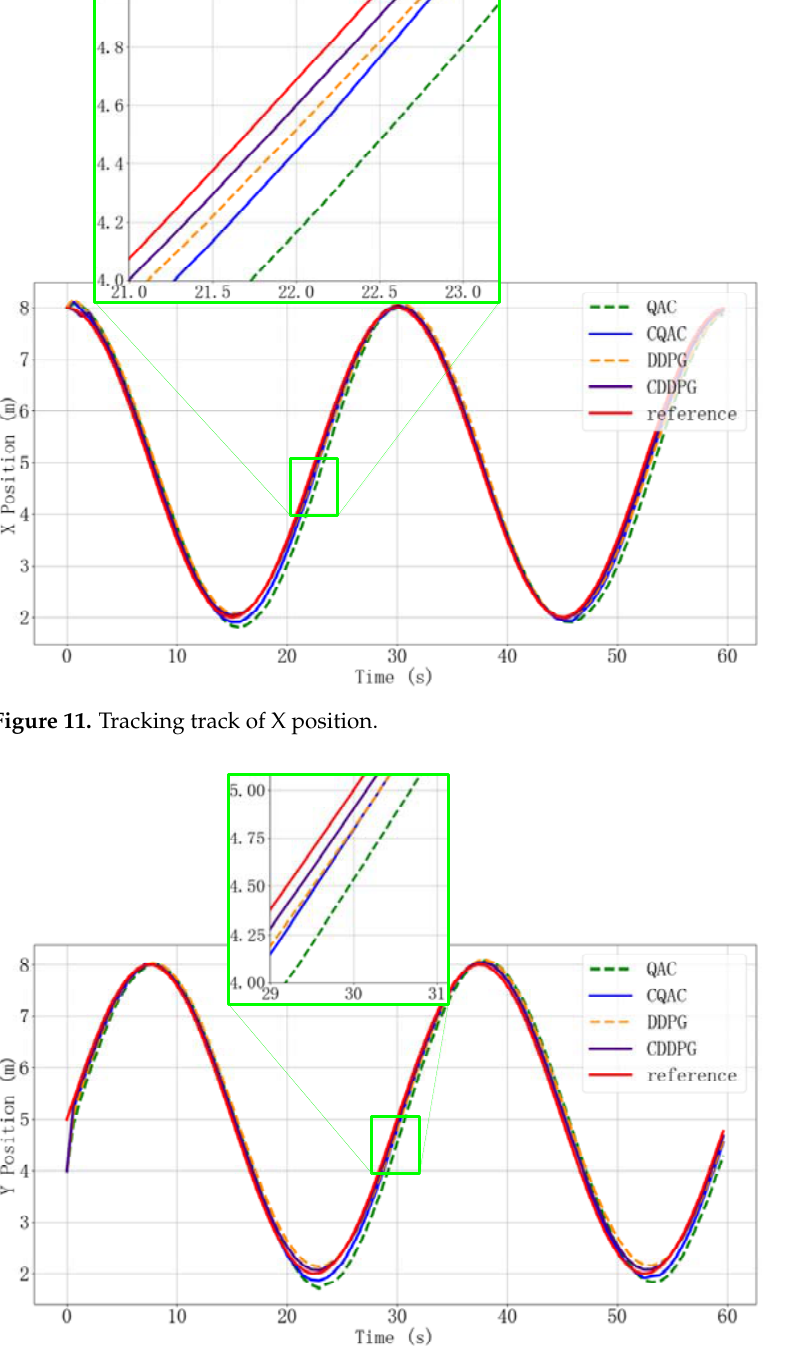
Figure 12. Tracking track of Y position.